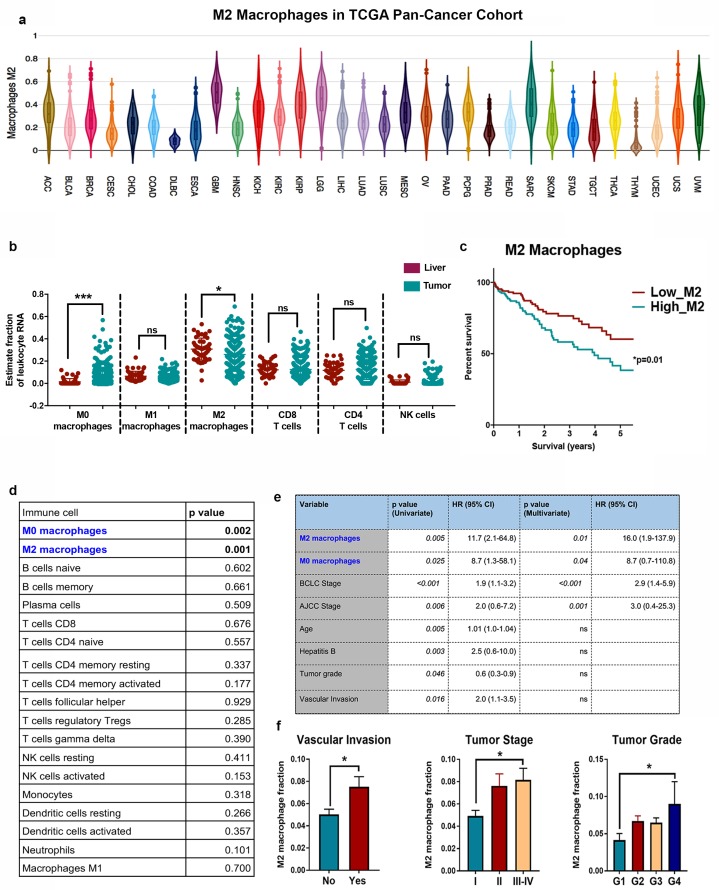
M2 macrophages have a prognostic role in human cancers including liver cancer.(a) M2 macrophage infiltration in 33 different cancers from the pan-cancer TCGA cohort based on transcriptome deconvolution analysis using CIBERSORT. (b) CIBERSORT analysis of human HCC TCGA RNAseq dataset (n = 373) to show major immune subset composition. (c) Kaplan Meier survival curve of TCGA human HCC (n = 373) stratified by median M2 macrophage infiltration. (d) Cox proportional hazard survival analysis of 22 immune compartments on survival of HCC patients in TCGA cohort (n = 373). (e) Multivariate survival analysis of factors independently influencing survival of HCC patients in TCGA cohort (n = 373). (f) Correlation of M2 macrophage infiltration with vascular invasion, tumor stage and tumor grade in human HCC (n = 373).